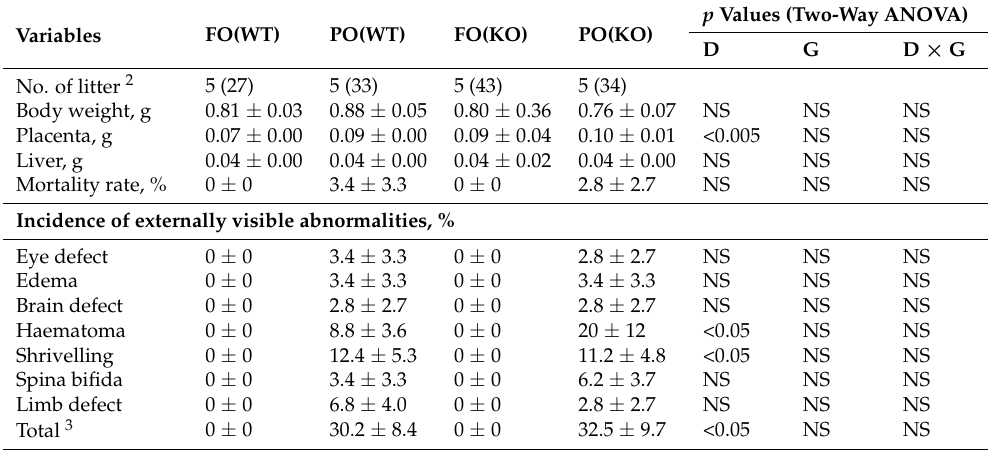
Table 3. Body and tissue weight, mortality, and externally visible congenital anomalies of fetuses from the wild (WT) and PPAR α knock out (KO) females receiving FO or PO diets during pregnancy 1 .